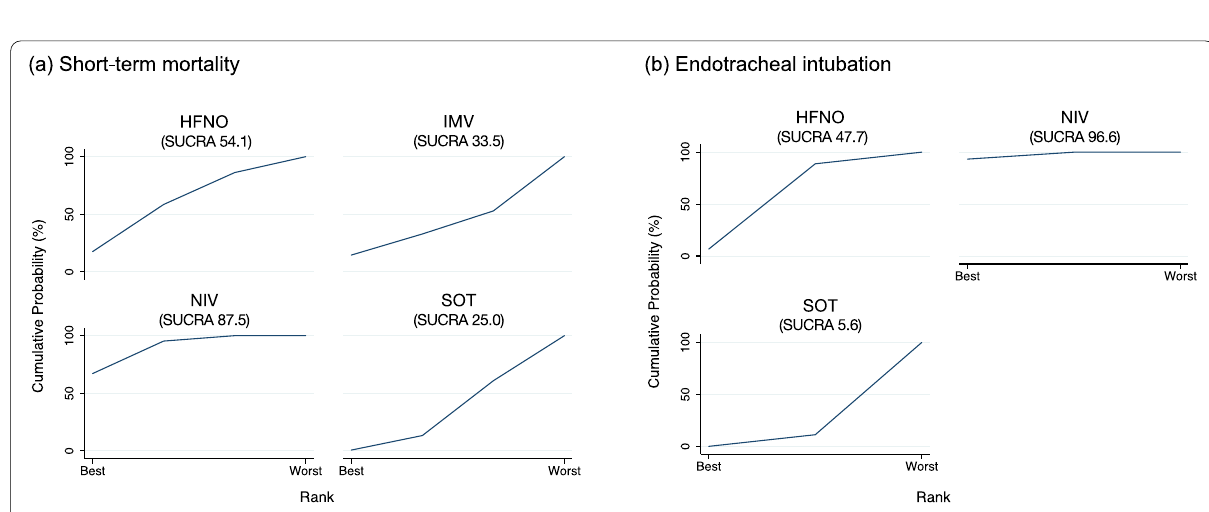
Fig. 4 Surface under the cumulative ranking of each noninvasive oxygen strategy for mortality and intubation: a short-term mortality, b endotracheal intubation. Abbreviations: HFNO (high-flow nasal oxygen), IMV (invasive mechanical ventilation), NIV (noninvasive ventilation), SOT (standard oxygen therapy), and SUCRA (surface under the cumulative